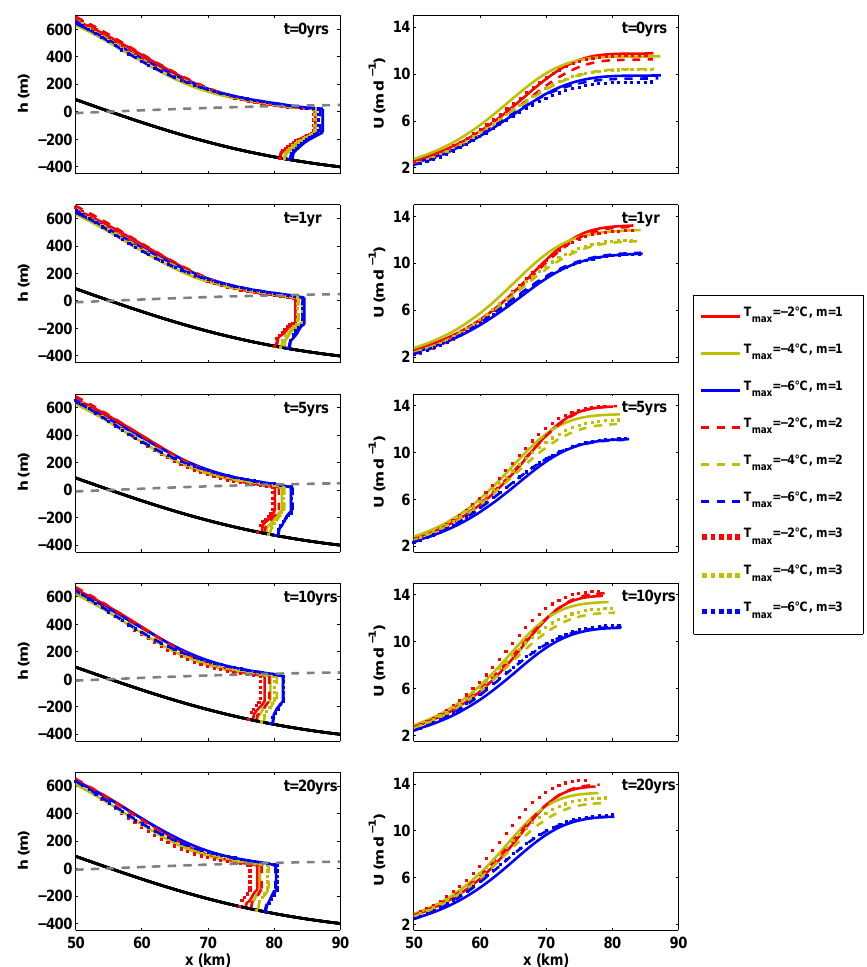
Fig. 5. Simulated profiles of (left panels) elevation and (right panels) speed at 0, 1, 5, 10, and 20yr after the step increase in submarine melt rates for simulations performed using the seaward-dipping bed profile. Profiles are shown for the model simulations with enhanced ice deformation (i.e., E =